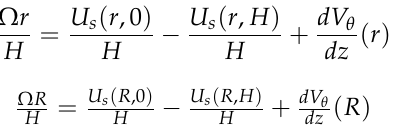
. γ , at the radial position, r , and dV θ ar γ  , at the radial position, r , and ar